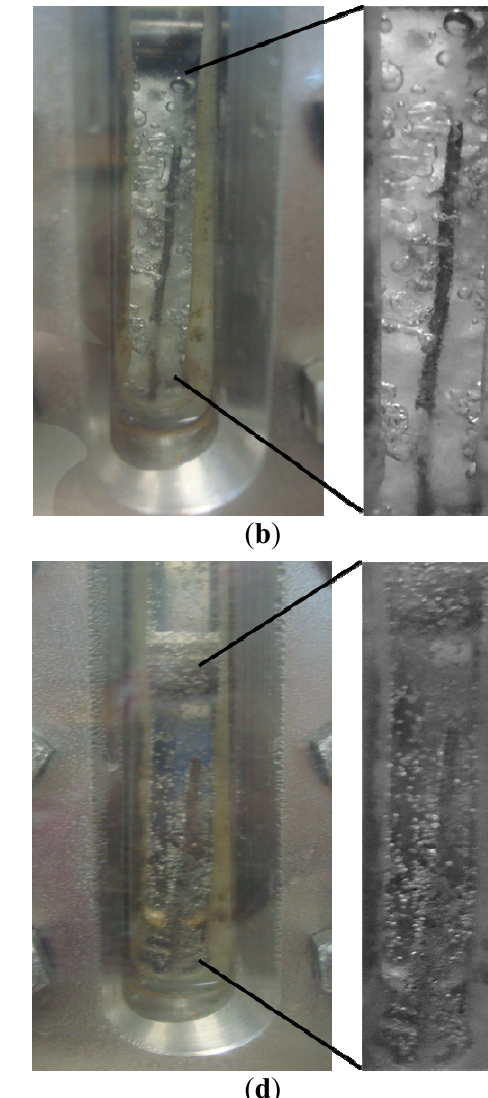
hydrate phase during Run 1 at 2 hydrates (density 2